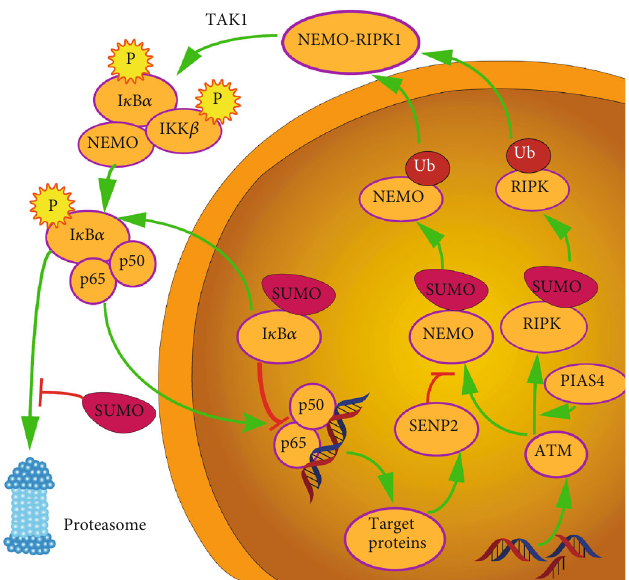
Figure 3: SUMOylation in the nuclear factor kappa-light-chain-enhancer of activated B cells (NF- κ B) pathway. The NF- κ B pathway is activated by DNA damage. Unlike the canonical NF- κ B pathway, NF- κ B signaling activated by genotoxicity requires ataxia-telangiectasia mutated (ATM) kinase, which results in the SUMOylation of NF- κ B essential modulator (NEMO). Protein inhibitor of activated STAT 4 promotes the SUMOylation of NEMO and RIPK. After SUMOylation, NEMO and receptor-interacting serine/threonine-protein kinase 1 (RIPK) are subsequently ubiquitylated and can then translocate into the cytoplasm to form a complex to recruit transforming growth factor-beta-activated kinase 1 (TAK1). The TAK1 kinase phosphorylates the inhibitor of nuclear factor- κ B (I κ B) kinase alpha (IKK α ) and IKK β . Following I κ B α phosphorylation, p65 and p50 are released and redistributed to nuclear and transcript target proteins. SUMOylation can decrease the NF- κ B-dependent gene expression by stabilizing I κ B α through competing with ubiquitylation and promoting the nuclear location of I κ B α . SENP2 induced by the activated NF- κ B pathway can deSUMOylate NEMO and inhibit the subsequent